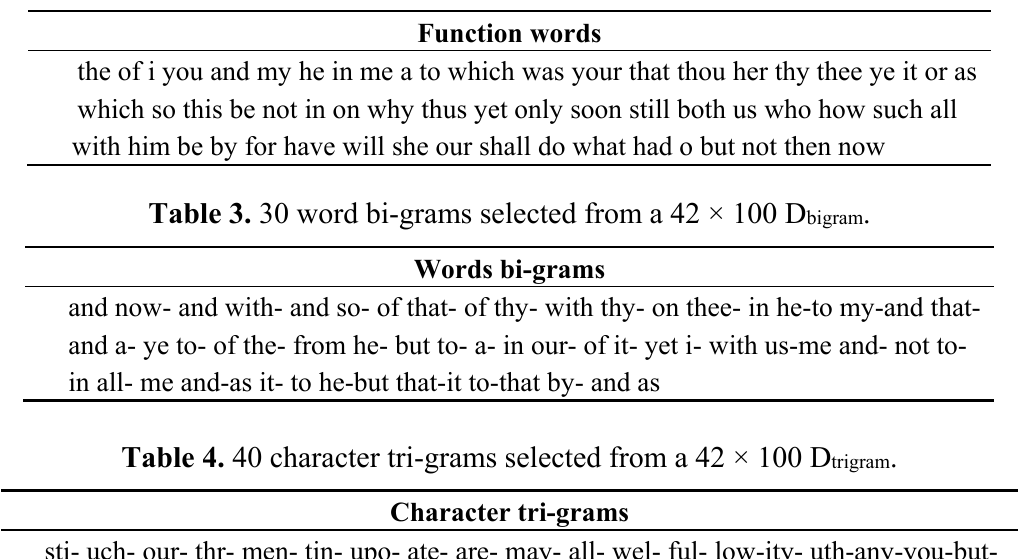
Table 2. 60 function words selected from a 42 × 135 D FW